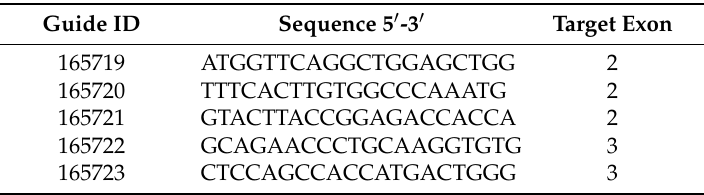
Table 1. Guide RNA (gRNA) sequences 1 for human FLOT1